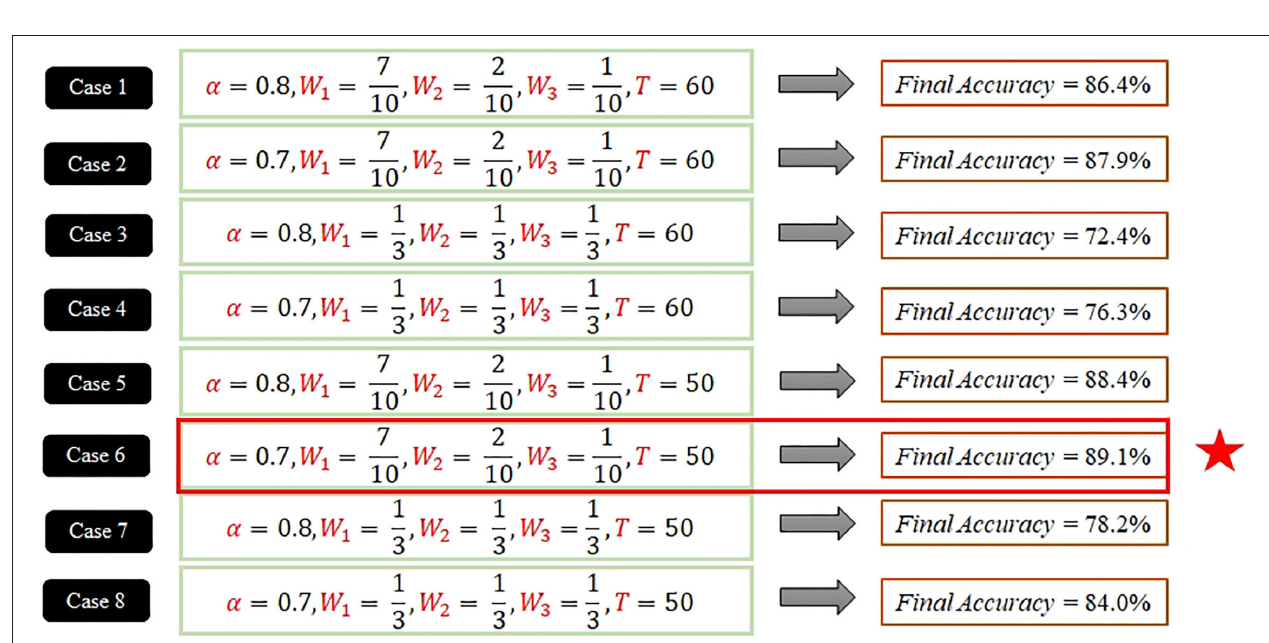
FIGURE 2 | Data learning and testing flow.